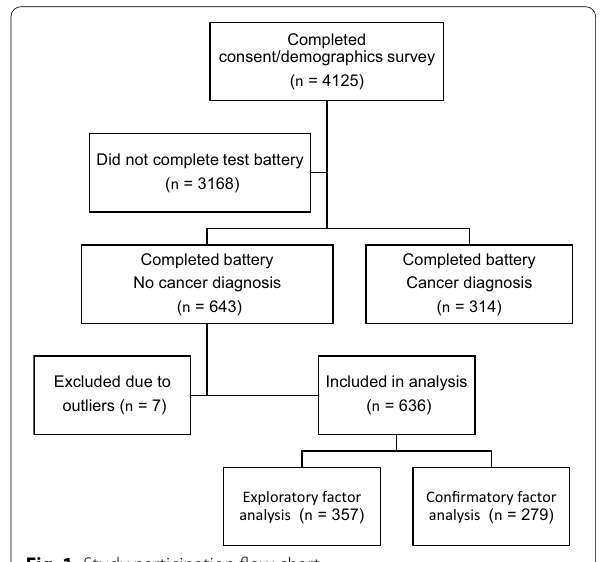
Fig. 1 Study participation flow chart